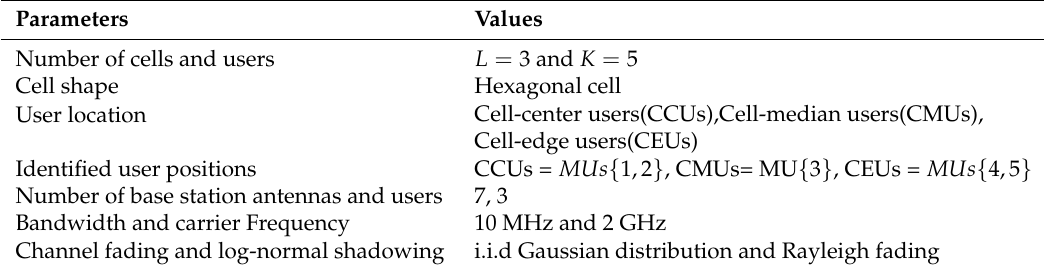
Table 4. Simulation